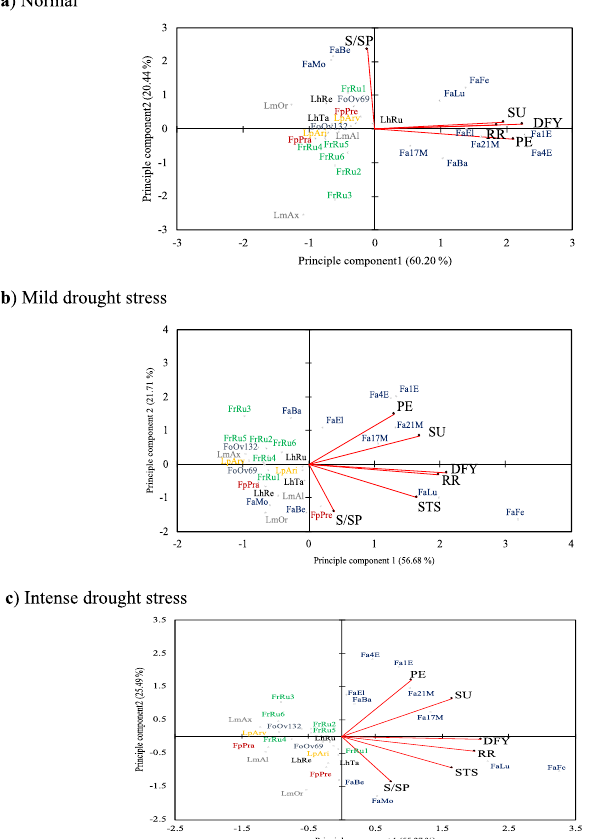
Figure 4. Biplot display of important traits of 28 genotypes of different grasses under three irrigation levels (normal, mild and intense drought stress). DFY dry forage yield, PE persistence, RR recovery rate, S/SP summer dormancy, STS stress tolerance score, SU